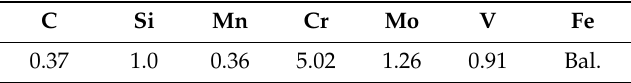
Table 1. Chemical composition of 4Cr5MoSiV1 die steel